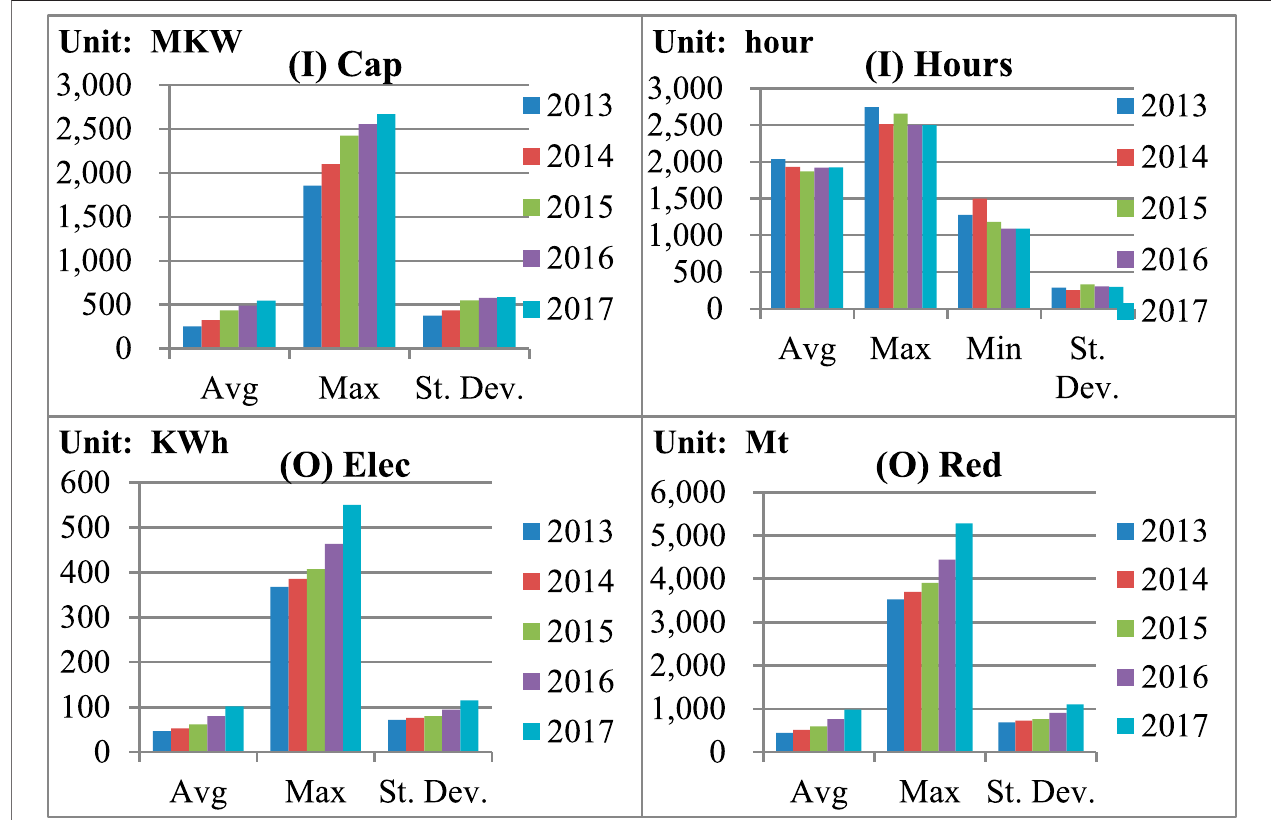
FIGURE 3 | Statistical description of indicators by